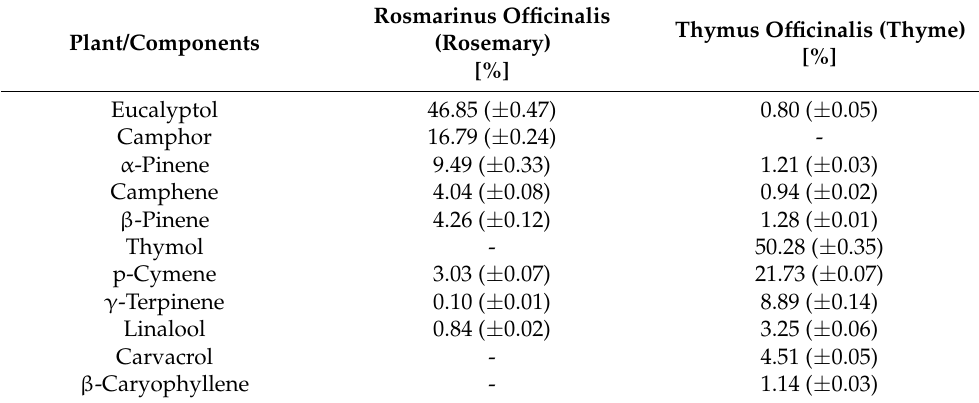
Table 1. Percentage content (integrated peak area) immediately after loading on FCC measured by extraction and GC-MS. Bold numbers indicate 5 most prevalent components in respective EO based on manufacturer data